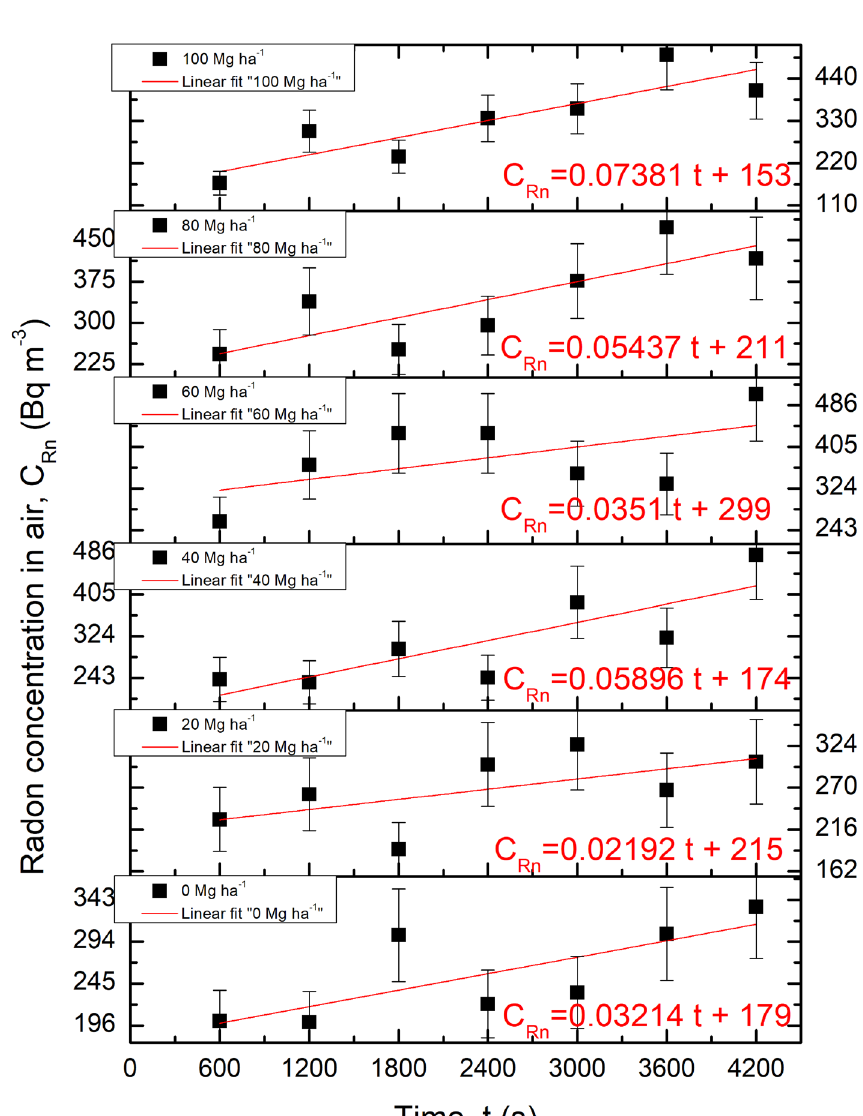
Figure 7. Results of radon accumulation expressed as the radon concentration in air (black squares) as a function of time for five investigated experimental fields and for the control field (denoted as 0 Mg ha −1 ). The linear fitting is presented as red lines and in the form of linear equations (in red). Errors presented for data points were calculated directly by the AlphaGUARD